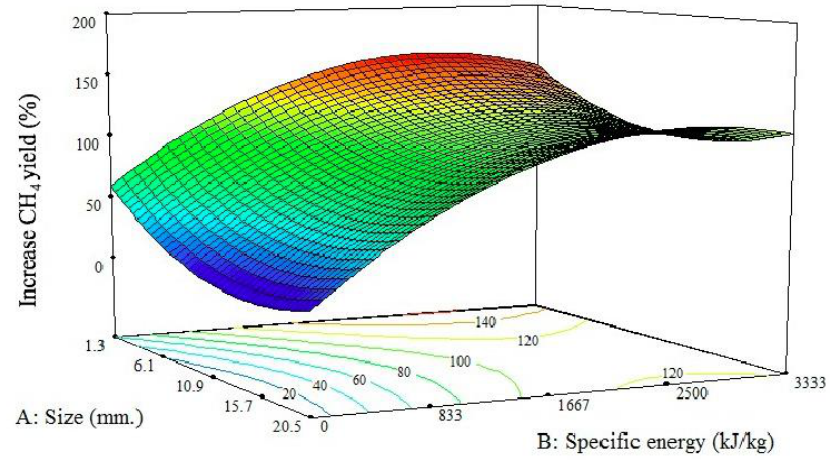
Figure 6. Surface and contour plot of the increase in methane yield as a result of size and specific energy in sonication